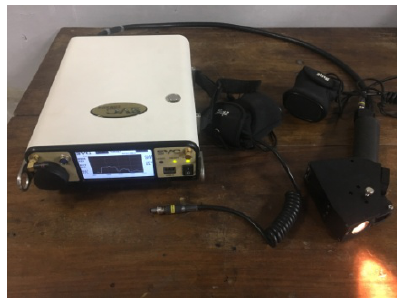
Figure 2.Sepctro-radiometer instrument set up Spectral Range